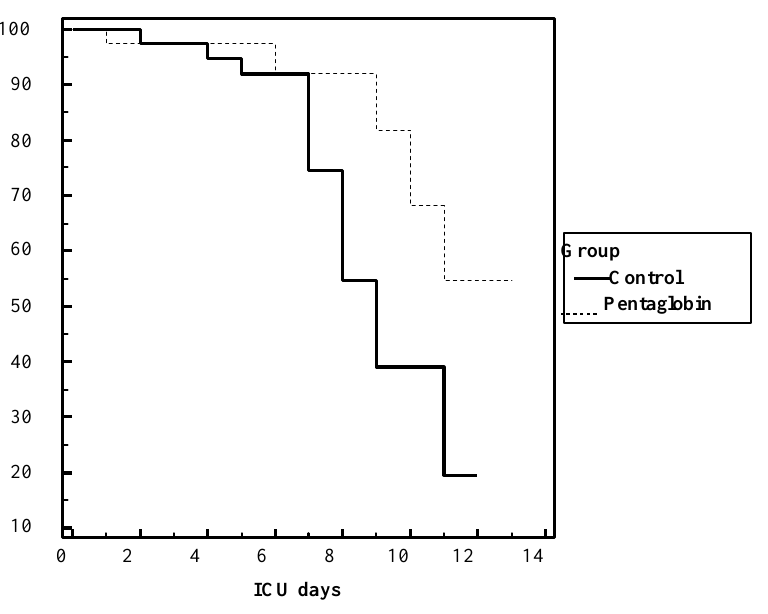
Figure 2. Kaplan-Meier survival